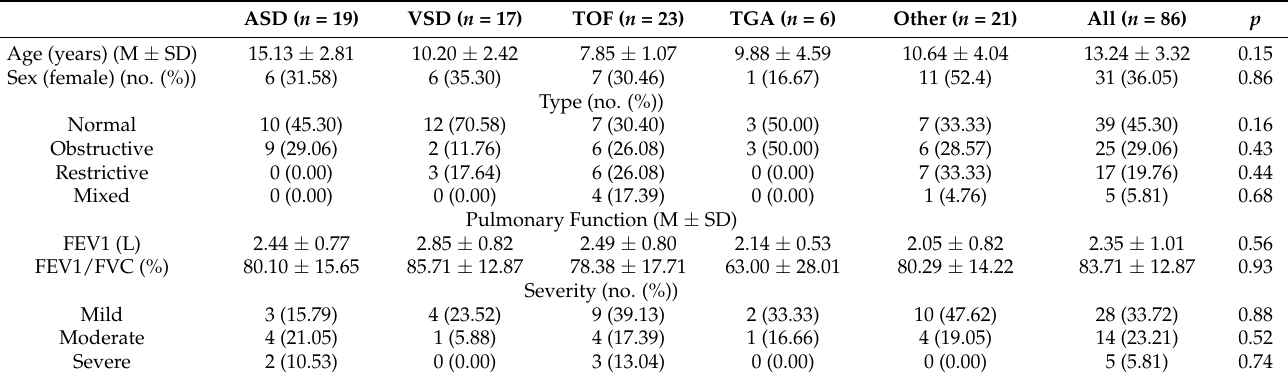
Table 1. Demographic and clinical characteristics of the patients at